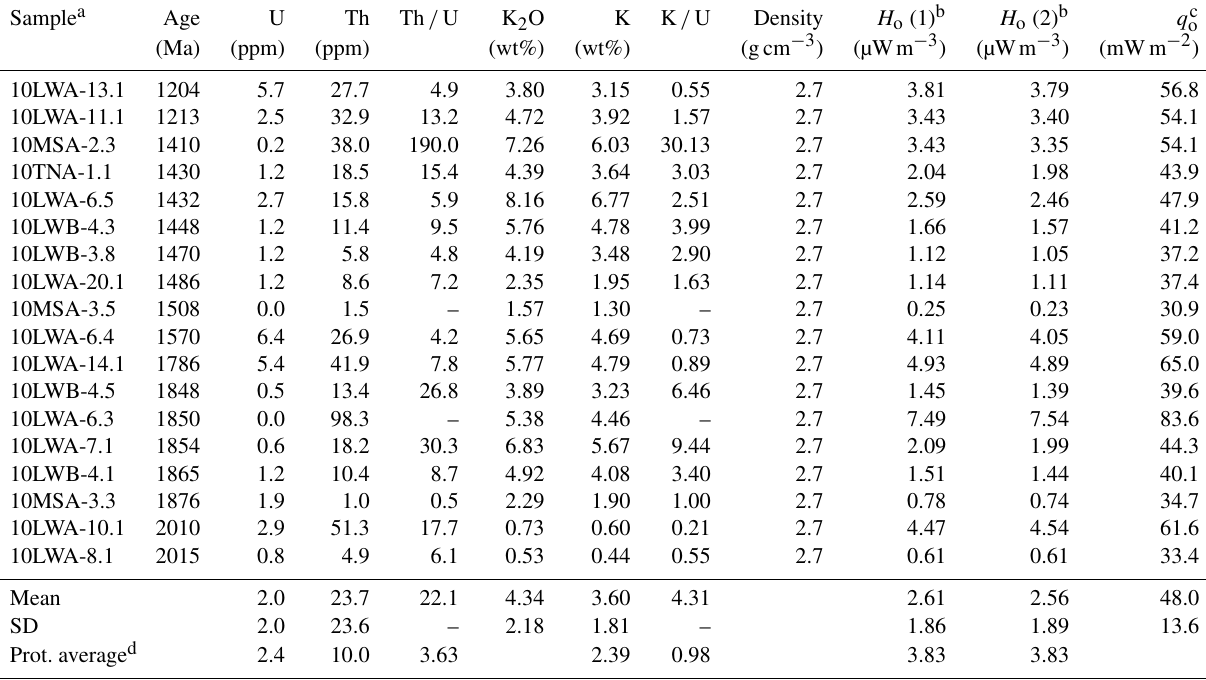
Table 1. Estimates of H o and q o for igneous clast samples, central East Antarctica. Sample